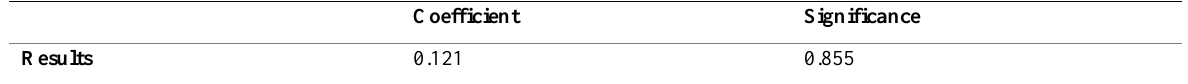
Table 3: Results of Different Tests of Financial distress Before and During the